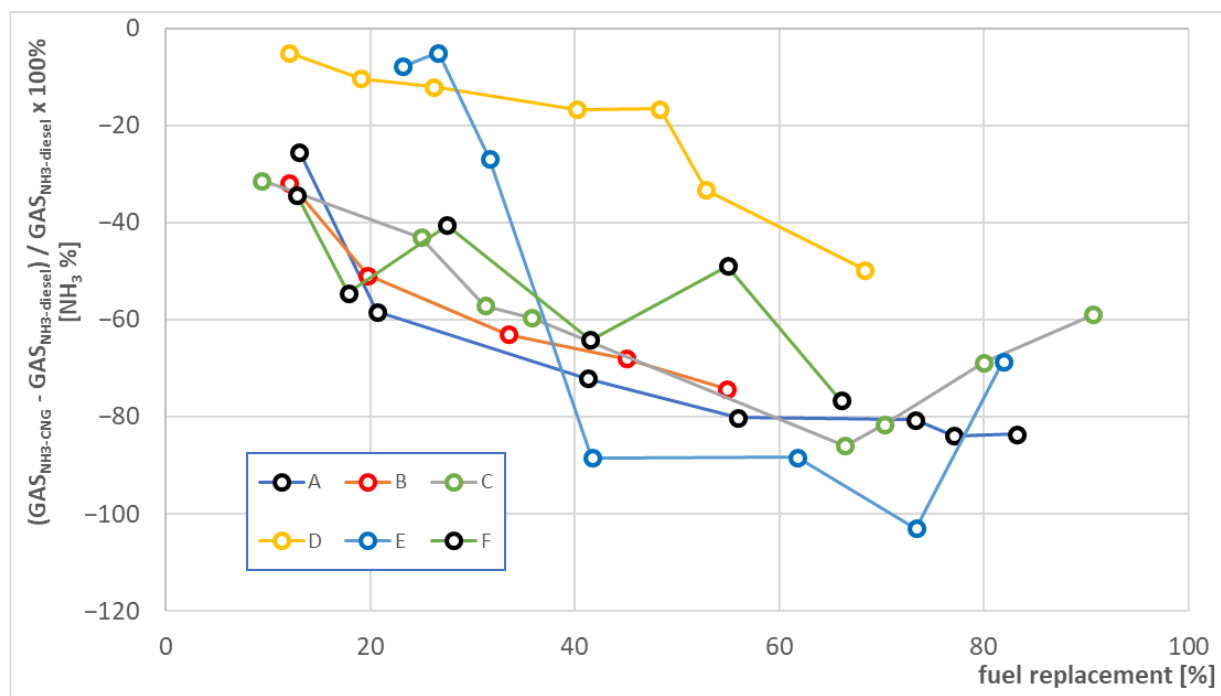
Figure 20. Curves from A to F showing the changes in the emission of ammonia as the comparison of exhaust gas temperature noted only in single fuel (diesel) working mode for individual engine operating points, where the rotation speed, power, and torque were constant, as a dual-fuel mode (where engine uses CNG and diesel fuel) replacement function.